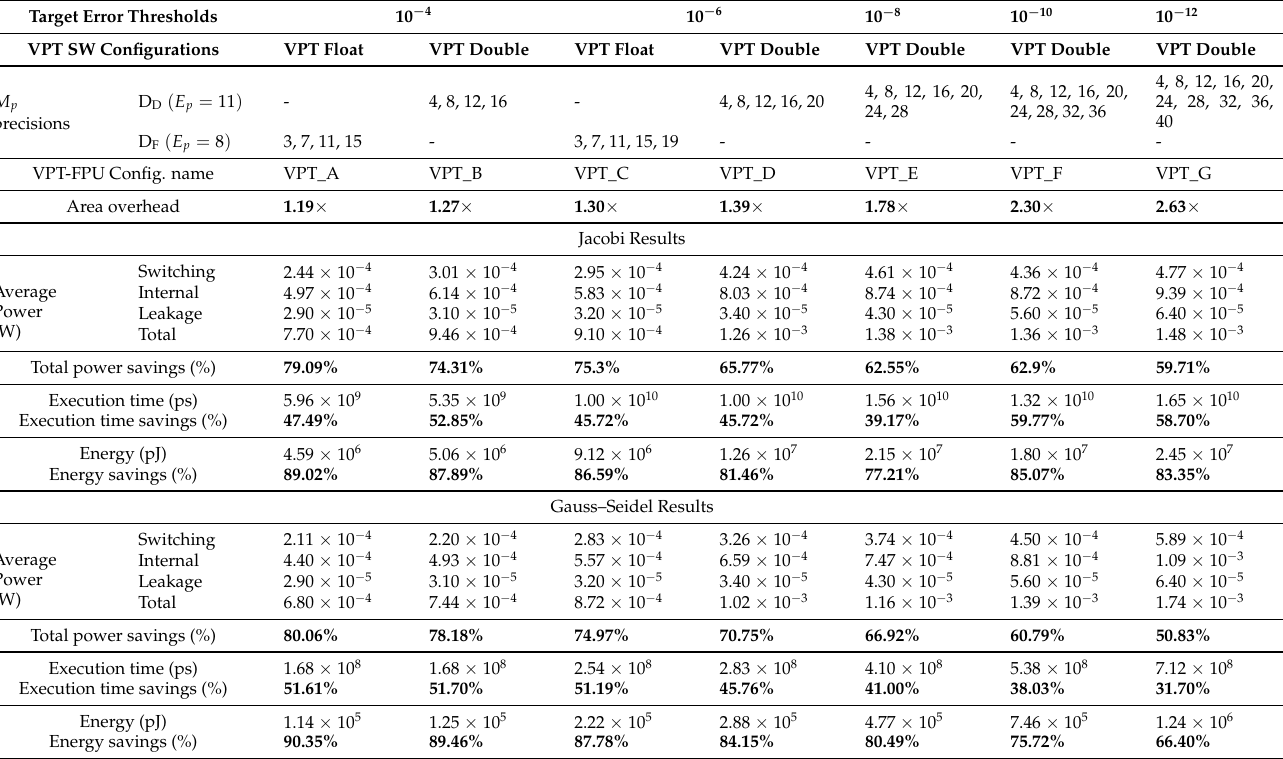
Table 1. Post-synthesis and gate-level simulation results for Jacobi and Gauss–Seidel applied to 1 input with relaxed thresholds ( (cid:101) M p